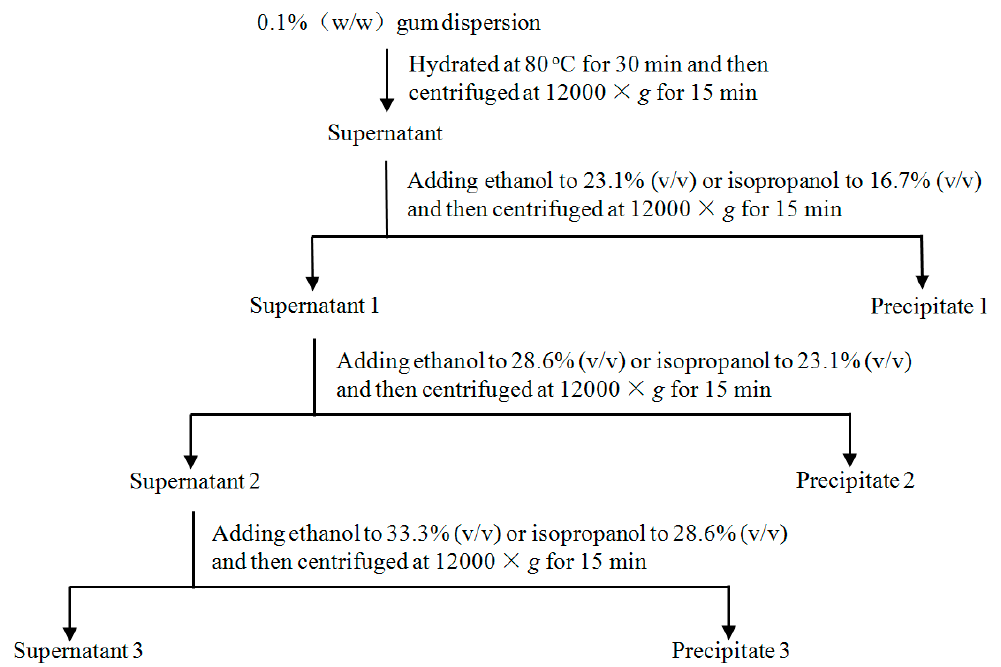
Figure 4. Scheme of the fractional precipitation of the two galactomannan gums of with ethanol and isopropanol.